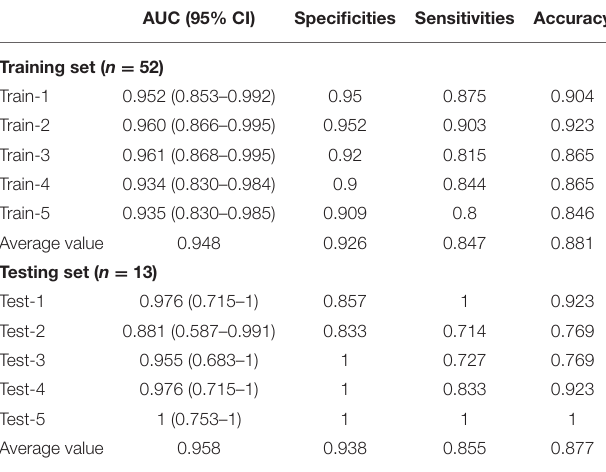
TABLE 2 | Diagnostic capacity of the CFD method in the training and testing sets.